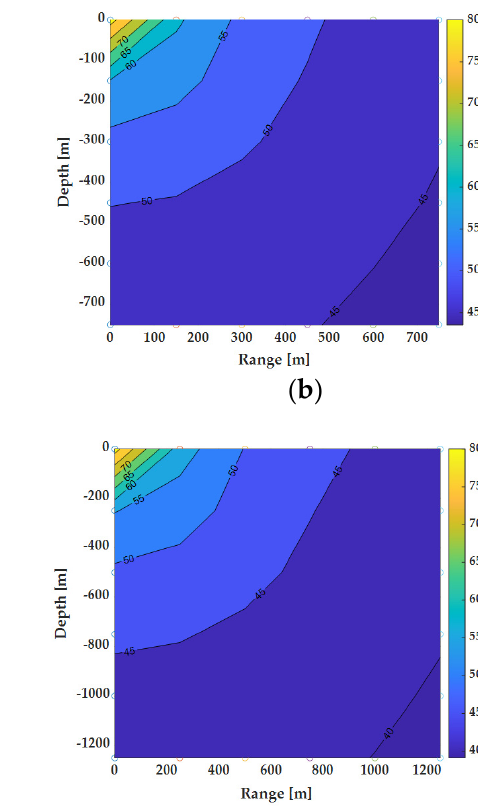
Figure 6. Acoustic field propagation at 250 m: ( a ) direct sound field; ( b ) reflection on the free side; ( c ) reflection on the sea floor; ( d ) direct and reflected field on the free side combination; ( e ) direct and reflected on the sea floor combination; ( f ) global sound field.